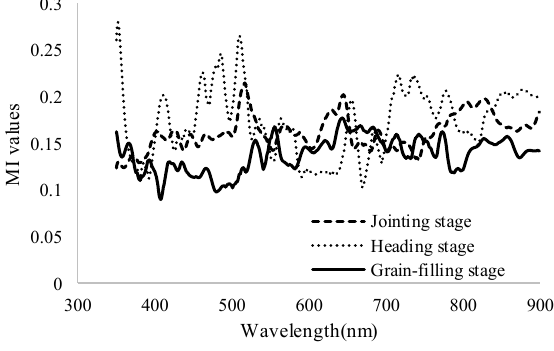
Figure 4. MI curves in the range of 350 nm–900 nm.